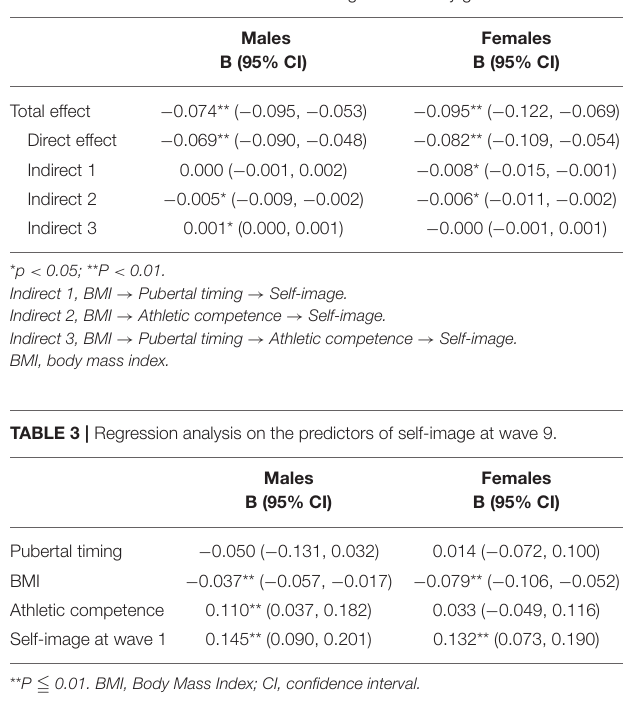
TABLE 2 | Bootstrap test on the effect of pubertal timing and athletic competence on the association between BMI and self-image stratified by gender. Males B (95% CI)